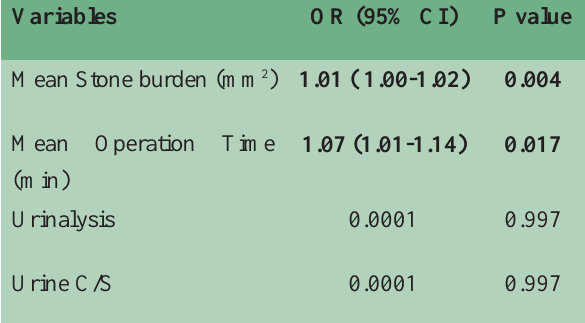
Table 6: Univariate analysis of factors between patients with and without post-operative Sepsis Variables OR (95%